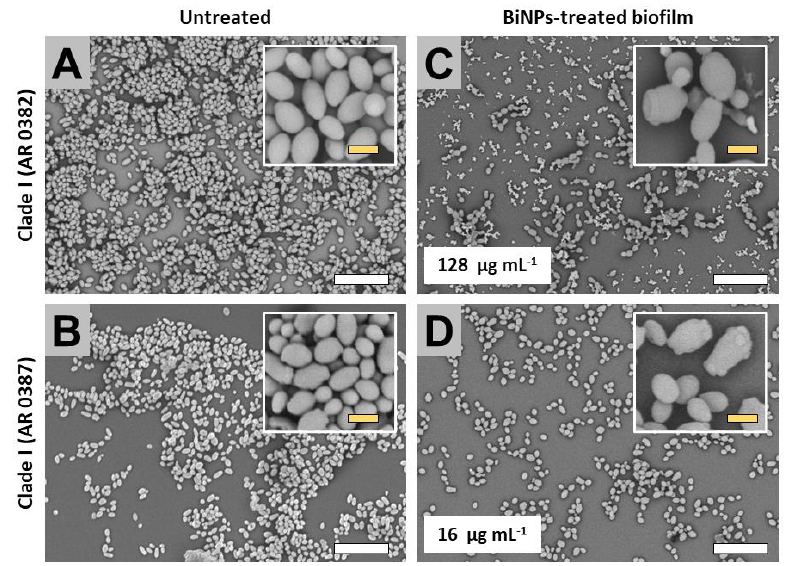
Figure 3. SEM observations on the BiNP antibiofilm activity on the C. auris strains from the Clade I (subgroup 2). BiNPs displayed an evident biofilm reduction—when compared to the untreated control—on the C. auris strains no. 0382 ( A , C ) and no. 0387 ( B , D ). The cell morphology also exhibited changes by the BiNPs (A–D). Scale bar: yellow 2 µ m, white = 20 µ